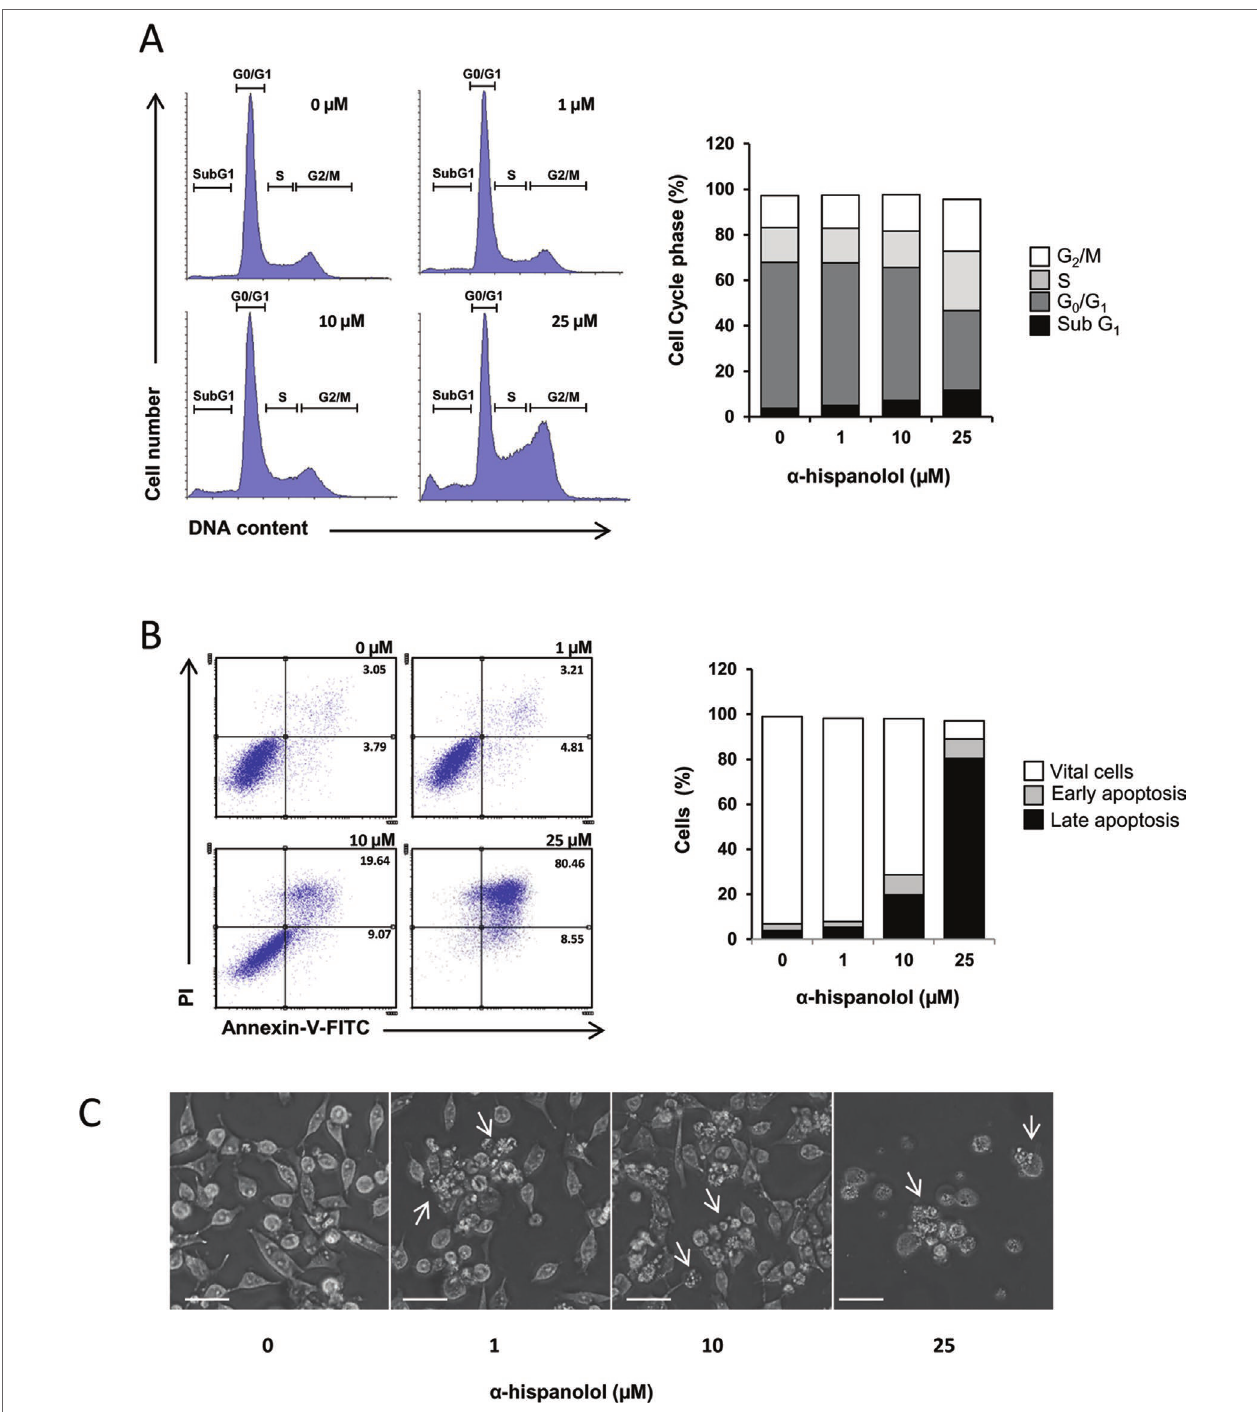
FIGURE 2 | Effects of α -H on cell cycle and apoptosis in U87 cells. (A) U87 cells were treated with different concentrations of α -H (1, 10, and 25 μM) or vehicle as control for 24 h, then fixed in ethanol, and stained with propidium iodide. DNA content was determined by flow cytometry. Percentage of cells in each phase of the cell cycle (sub-G 1 , G 0 /G 1 , S, and G 2 /M) showed in the bar graph were calculated using Flowing software. (B) U87 cells were treated with different concentrations of α -H (1, 10, and 25 μM) or vehicle as control for 24 h. Collected cells were stained with annexin V-FITC and propidium iodide, and then analyzed by flow cytometry. Numbers in the plots represent percentage of the correspondent apoptotic population. Graph bars show percentage of correspondent cellular phenotype. (C) Microphotographs were taken after 24 h of incubation with different concentrations of α -H or vehicle as control. Characteristics of apoptosis such as cell rounding (due to loss of adhesion to substratum) and plasma membrane blebbing are observed in α -H-treated cells (arrows) (scale bars = 40 µ m). Data presented are from one representative experiment out of